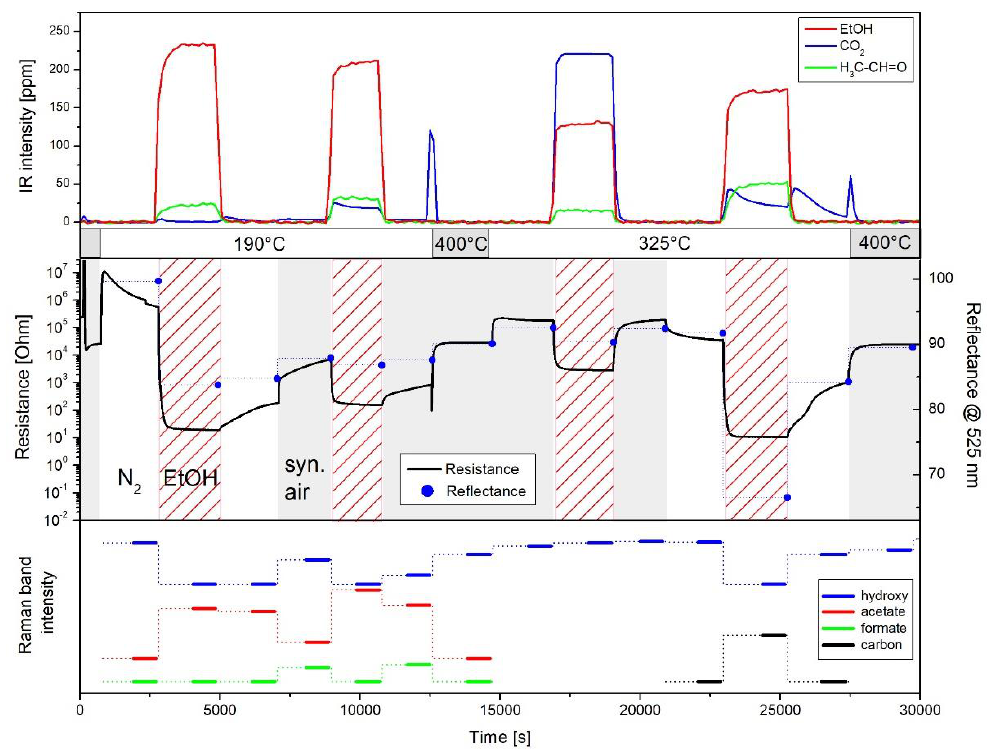
Figure 12. Temporal correlation of spectroscopic data and sensor resistance of the combined operando UV-Vis/Raman (514.5 nm)/IR experiment during ethanol gas sensing of SnO 2 . Dashed lines are a guide to the eye. Raman band intensities of hydroxy and acetate species are offset for clarity. Reproduced from